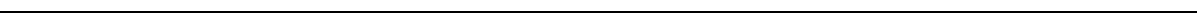
Fig. 3 The conformation of neuro fi bromin 2 dictates its binding. a Lipid co-sedimentation analysis of the PIP 2 binding to wild type and our lipid binding de fi cient mutant neuro fi bromin 2. wild-type neuro fi bromin 2 (residues 1 – 339) is soluble in the absence of PIP 2 and pellets in the presence of PIP 2 . Mutant (T59V, W60E, R309Q, R310Q) neuro fi bromin 2 (residues 1 – 339) remains soluble in the absence and presence of PIP 2 . S supernatant, P pellet, WT wild type, LBD lipid binding de fi cient. b Lipid co-sedimentation analysis of the PIP 2 binding to wild-type and disease-derived mutant neuro fi bromin 2. Wild-type neuro fi bromin 2 (residues 1 – 339) is soluble in the absence of PIP 2 and pellets in the presence of PIP 2 . Mutant (W60C) neuro fi bromin 2 (residues 1 – 339) is soluble in the absence of PIP 2 , while a small fraction pellets in the presence of PIP 2 . S supernatant, P pellet, WT wild type. Microscale thermophoresis (MST) measurements show the binding of PIP 2 to c wild-type full-length neuro fi bromin 2 ( K d = 8.02± 0.91 μ M) or to d our lipid binding de fi cient (LBD) mutant (T59V, W60E, R309Q, R310Q; K d = 859.23 ± 184.65 μ M). MST measurements show binding of LATS1 (residues 69 – 100) to e wild type ( K d = 39.31 ± 4.25 μ M), f the neuro fi bromin/PIP 2 complex ( K d = 3.77 ± 0.72 μ M), or g to our LBD neuro fi bromin 2 mutant ( K d = 175.54 ± 34.49 μ M). No binding was observed for the arti fi cially closed A585W-R588K (AR) mutants to h PIP 2 , or i LATS1. Error bars represent ±S.D., n = 3 (three independent measurements with the same laser